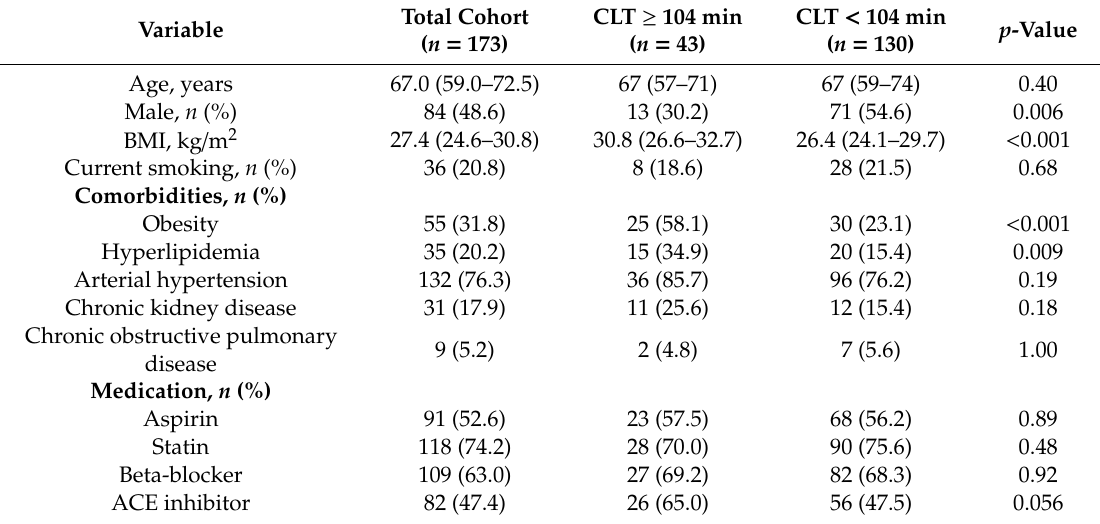
Table 1. Characteristics of patients with aortic stenosis (AS). The top quartile of clot lysis time (CLT) corresponds to 90th percentile of CLT in apparently healthy subjects (106